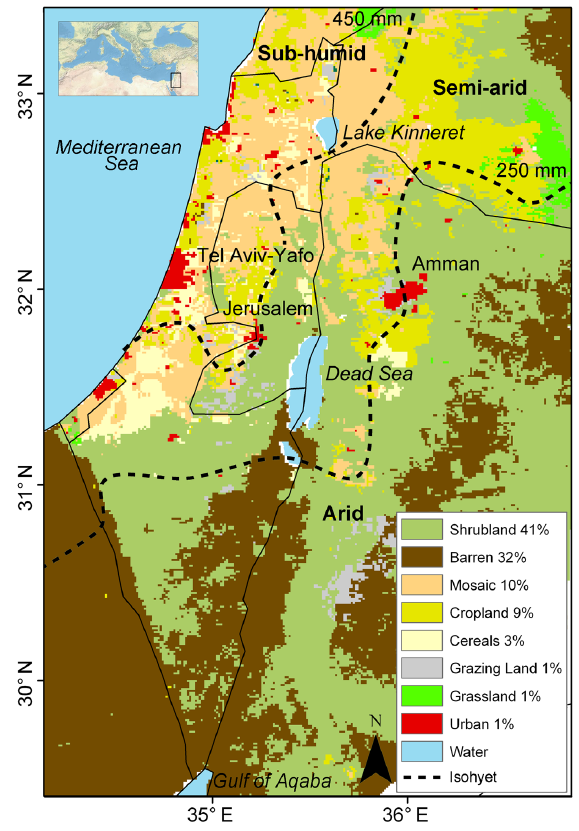
Fig. 1. Location of the study region (based on the ESRI World Phys- ical Map) and land uses with spatial coverage in percentages. Also shown are the 250 and 450mm isohyets derived from spatially in- terpolated precipitation data. These smoothed lines define a sub- humid, semi-arid and arid